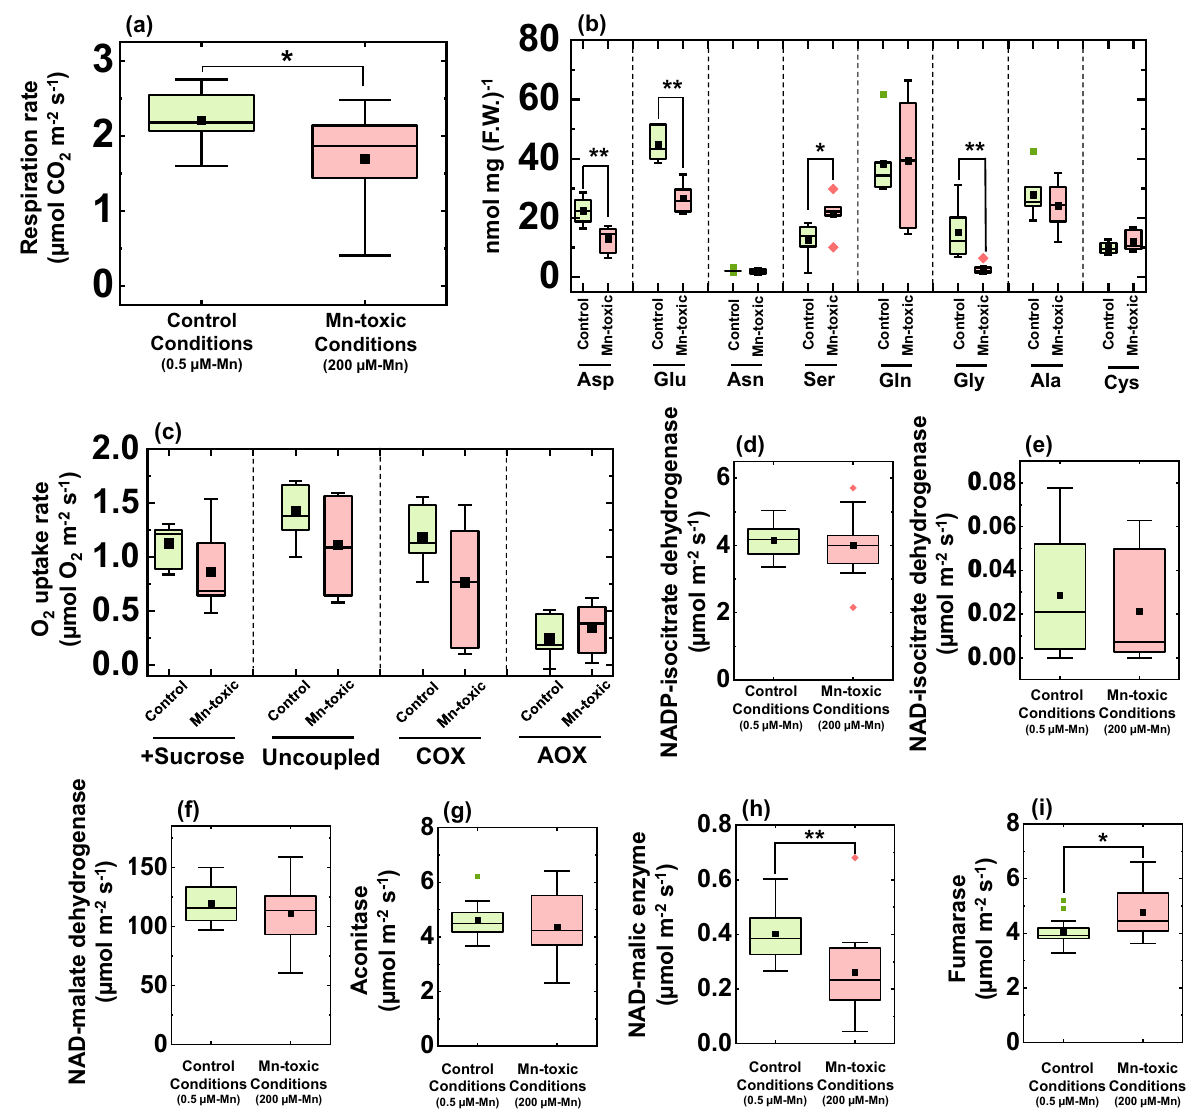
Figure 5. Mitochondrial respiration activities and amino acid contents in leaf blades grown under control and Mn-toxic conditions. ( a ) Leaf respiration rate (n = 12–13) in the dark and ( b ) sucrose feeding respiration activities and mitochondrial respiratory electron transport activities depending on ATP synthase (uncoupled), COX, and AOX (n = 7). ( c ) Amino acid content in leaves sampled in the middle of the night (n = 6). ( d – i ) Enzyme activities involved in the TCA cycle (n = 13–14). Data are shown as box plots, black squares indicate the mean value, and bars indicate the range of the maximum or minimum data within a 1.5 × interquartile range (IQR). All data were obtained from independent biological replicates according to the indicated numbers. The green boxes indicate the results under control conditions, and the red boxes indicate those under Mn-toxic conditions. Asterisks represent significant differences between the control and Mn-toxic conditions (* p < 0.05, ** p < 0.01, Kruskal–Wallis